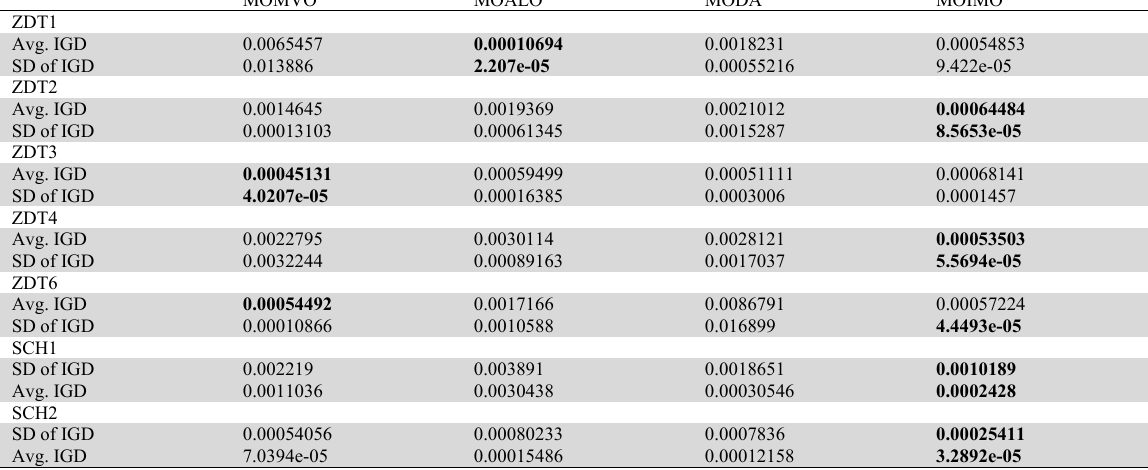
Results of the multiobjective algorithm (using IGD) on the unconstrained test functions MOMVO